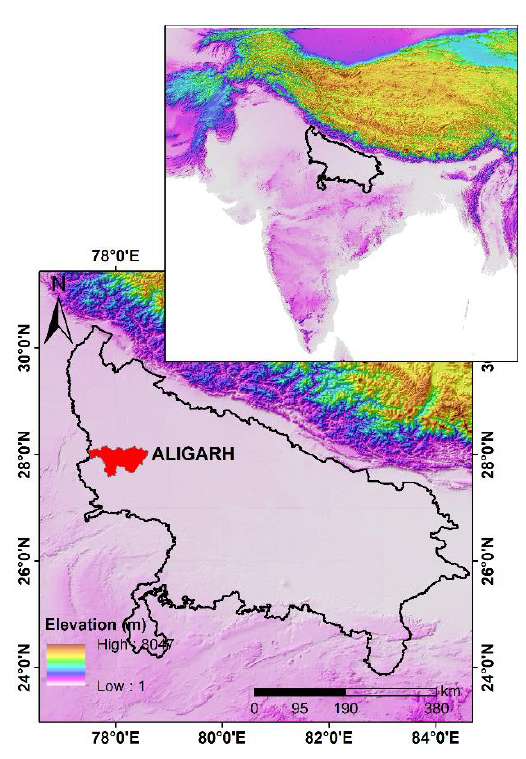
Fig 1 . Location map of the study area i.e. Aligarh district.